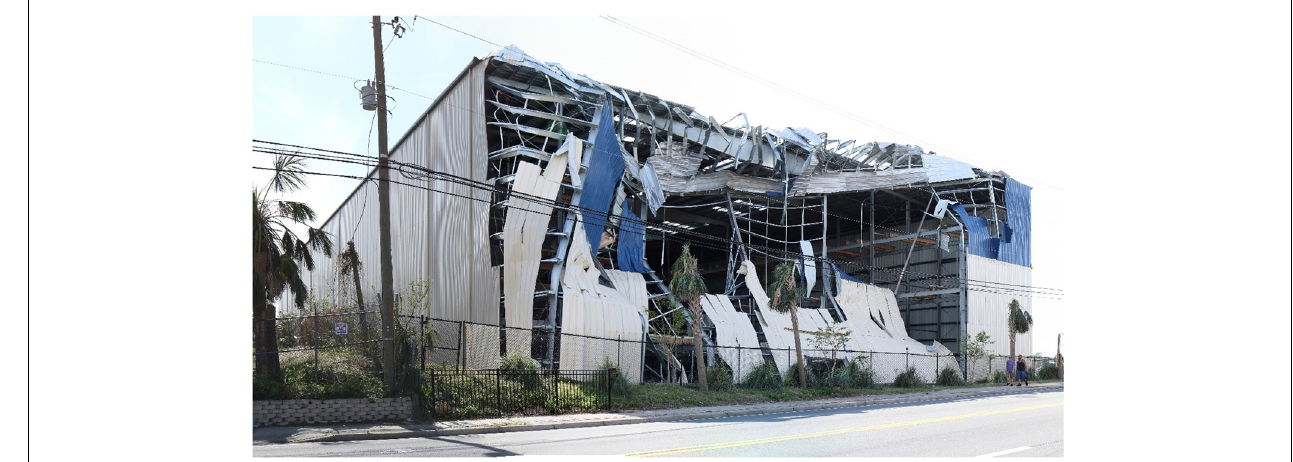
FIGURE 5 | Partially collapsed marine storage building in Panama City, FL.